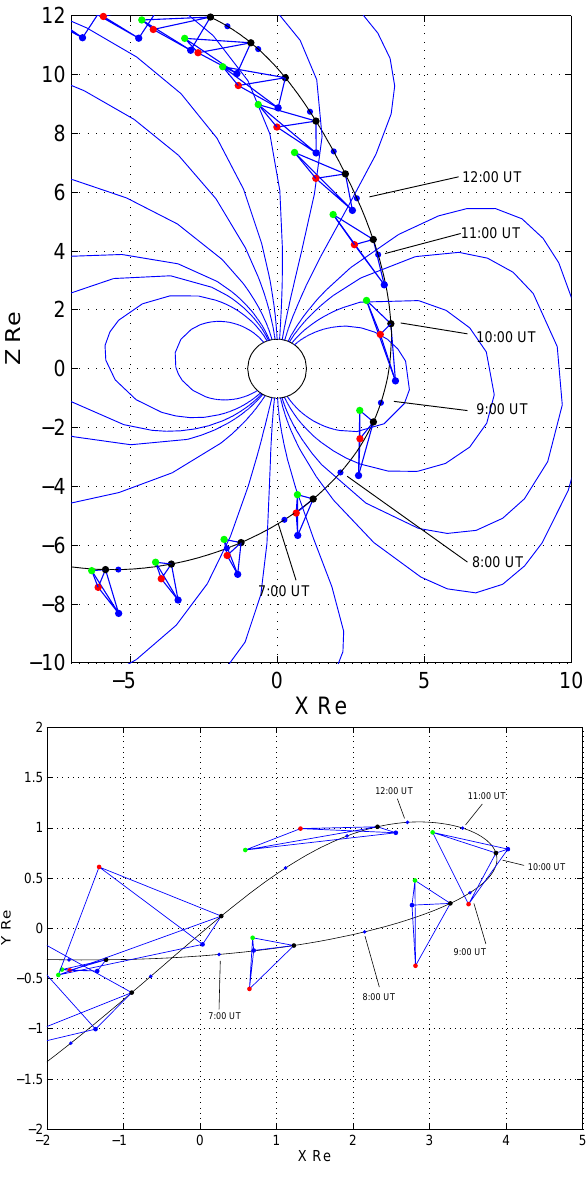
Fig. 2. The Cluster orbit between 03:00 and 17:00 on 24 August 2000 in the X − Z SM plane (top panel) and X − Y SM plane (bottom panel). The spacecraft are colour-coded (black, red, green and blue for spacecraft 1–4, respectively). The relative position of spacecraft 4 is shown even though there is no magnetometer data available. The blue dots denote the time, measured every hour. Magnetic field lines based on the Tsyganenko (1989) model are superimposed for context. The spacecraft separations shown are 20 times larger than in reality. The spacecraft configurations are shown at a time corre- sponding to the location of spacecraft 1 (black) along the